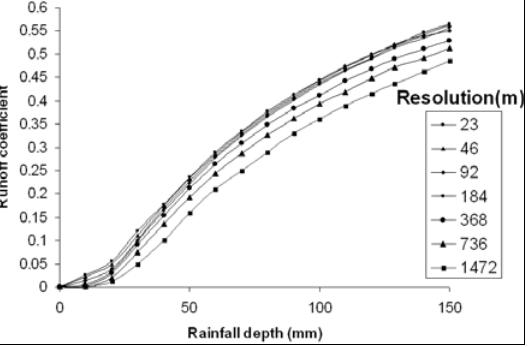
Figure 3. Effect of grid resolution on runoff